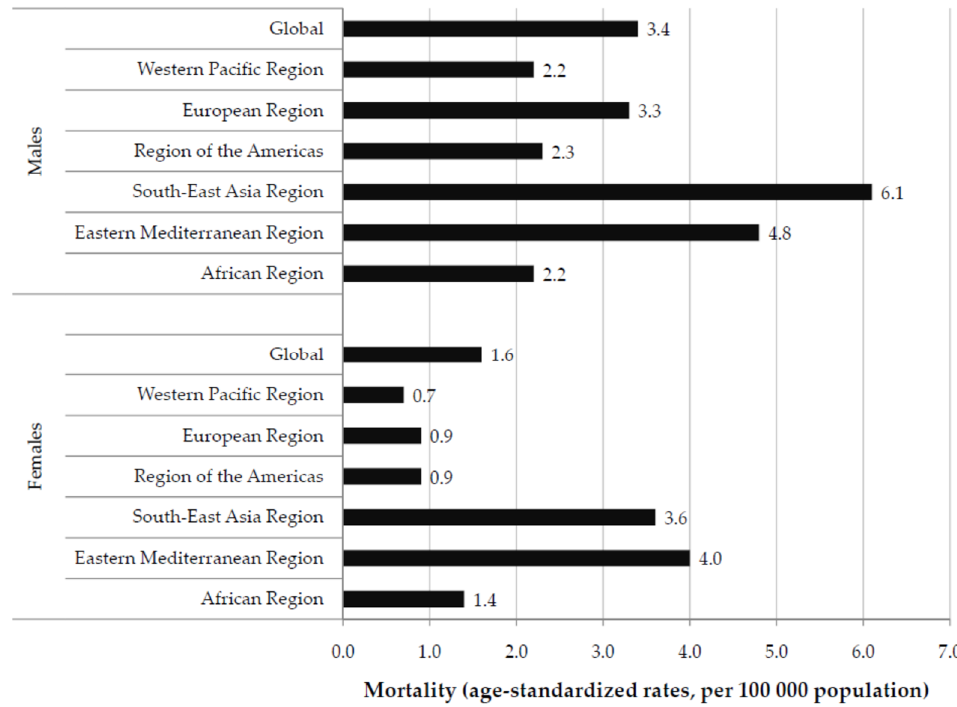
Figure 1. Mortality of lip and oral cavity cancer (global and by regions), by sexes, in 2019. Over the 1990–2019 period, the global ASRs of LOC cancer mortality significantly decreased in males (AAPC = − 0.2%, 95%CI = − 0.3 to − 0.2), but significantly increased in females (AAPC = 0.2%, 95% CI = 0.1–0.3) (Figure 2). According to the comparability test, global trends in mortality of LOC cancer in males and females were not parallel (final selected model rejected parallelism, p < 0.05).